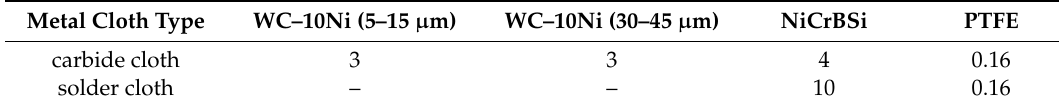
Figure 1. Microscopic morphology of various powders: ( a ) 30 – 45 μ m WC – 10Ni, ( b ) 5 – 15 μ m WC – 10Ni, and ( c ) BNi2. Table 3. Proportion of components in the metal cloth.